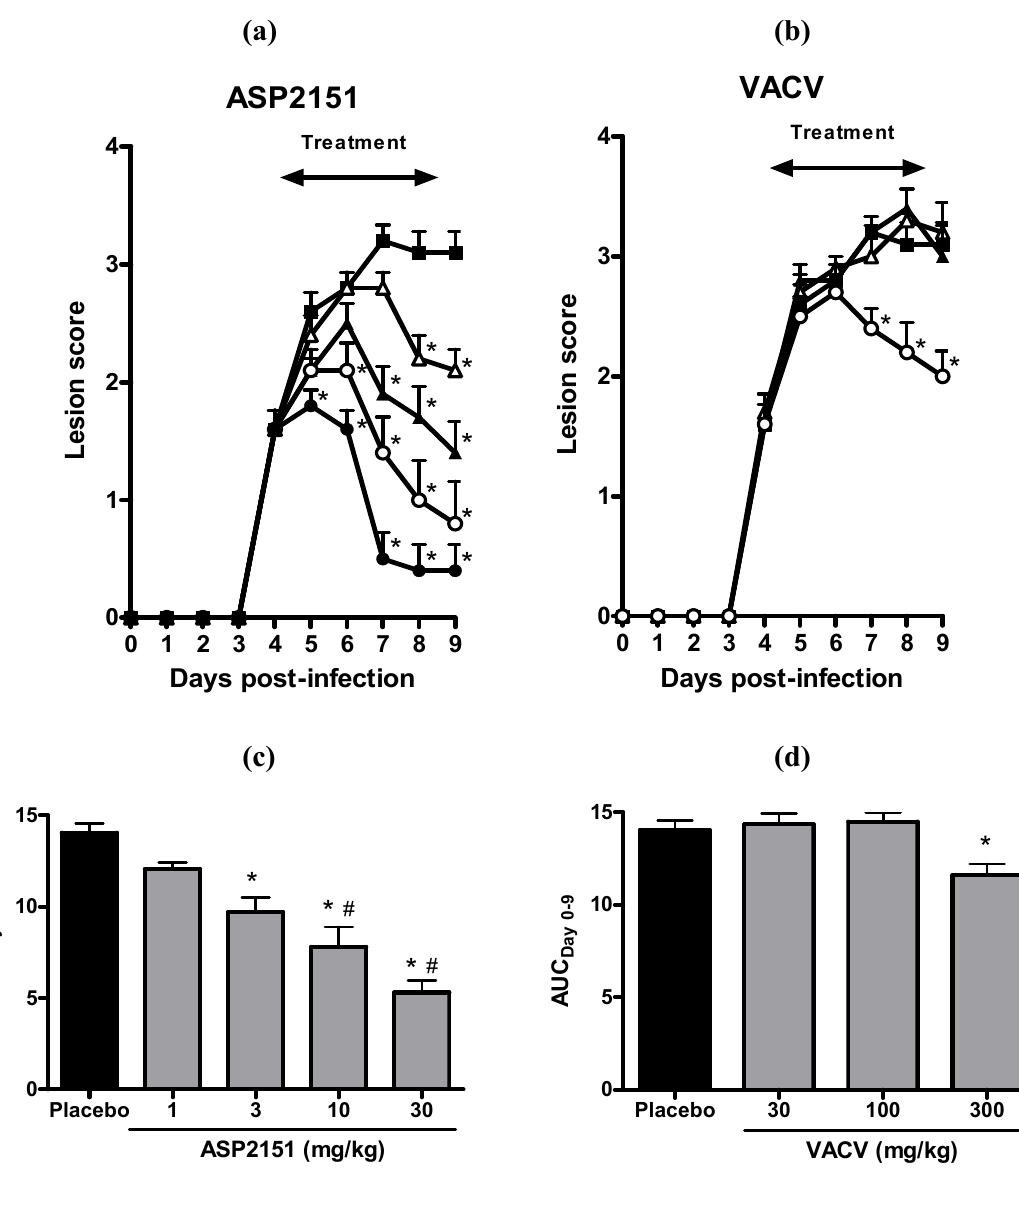
Figure 3. Therapeutic efficacies of ASP2151 and VACV on genital herpes symptoms in a guinea pig model of HSV-2 infection. Guinea pigs vaginally infected with HSV-2 were orally administered placebo (closed square); ASP2151 at a dose of 1 (open triangle), 3 (closed triangle), 10 (open circle), or 30 mg/kg (closed circle); or VACV at a dose of 30 (open triangle), 100 (closed triangle), or 300 mg/kg (open circle) twice daily from Days 4 to 9 post-infection. The mean disease scores for each ASP2151- (a) or VACV-treated (b) groups were calculated and plotted against days post-infection. * P < 0.05, compared with the placebo group (Dunnett’s multiple comparison test); (c) and (d) represent the area under the disease score-time curve from Days 0 to 9 post-infection. Data are expressed as the mean + SE of 10 animals per group. * P < 0.05, compared with the placebo group (Dunnett’s multiple comparison test). # P < 0.05, compared with the AUCs of valaciclovir 300 mg/kg treatment group (Tukey’s multiple comparison